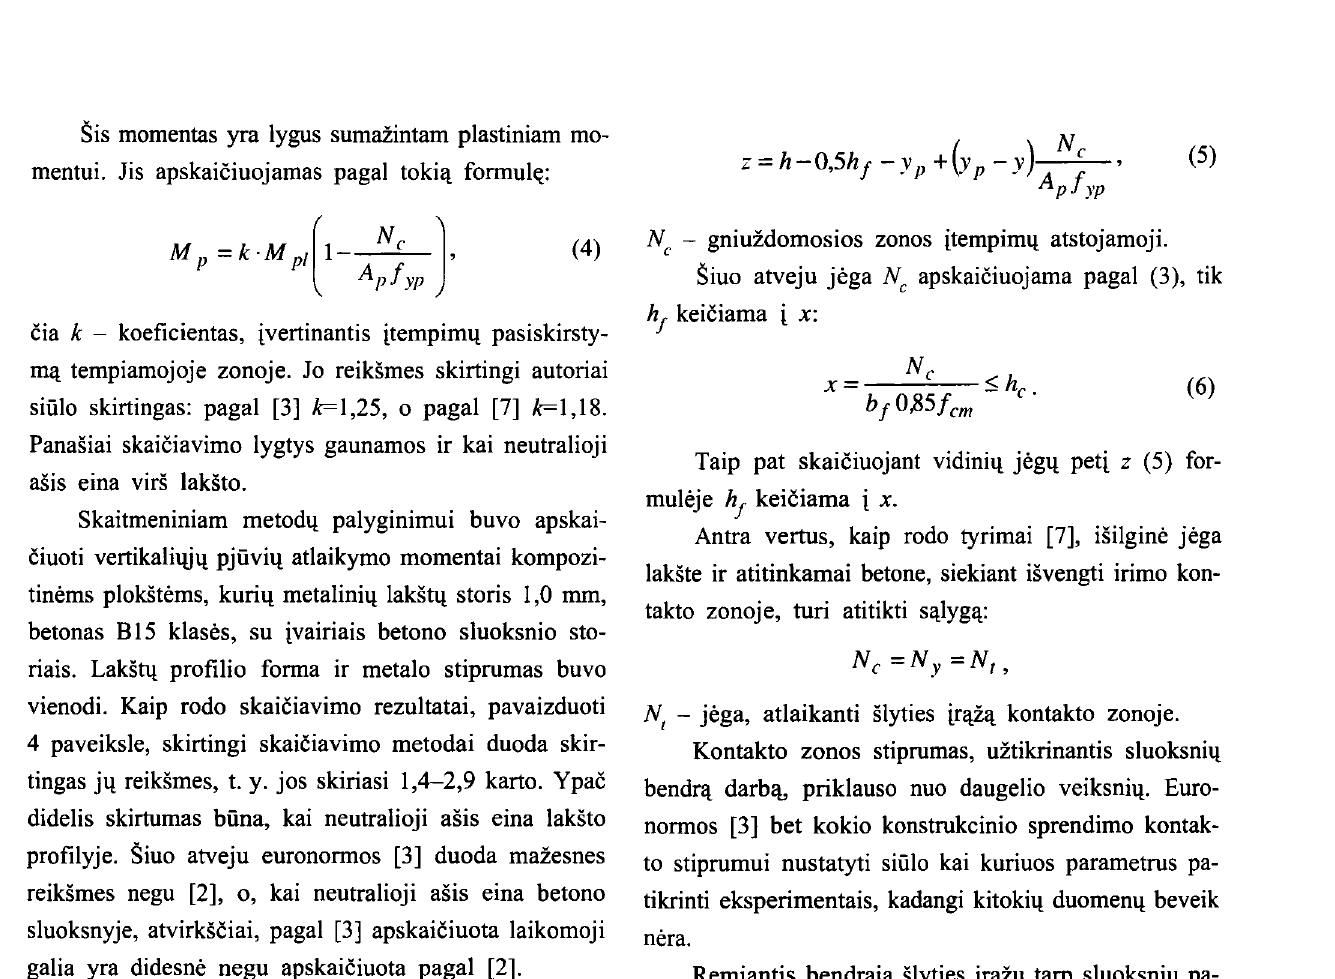
b - kontakto plokstumos plotis; T:u,mid - vidutiniai sly ties itempimai.